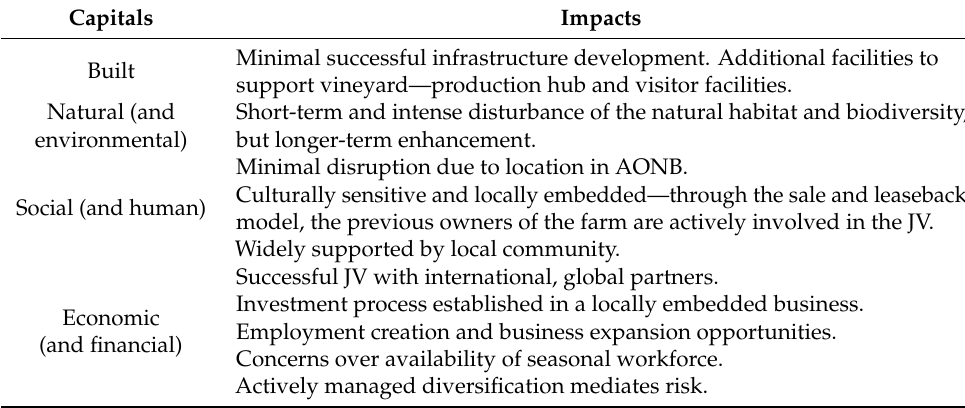
Table 2. Capitals, change variables, and their interpretation: Domaine Evremond.